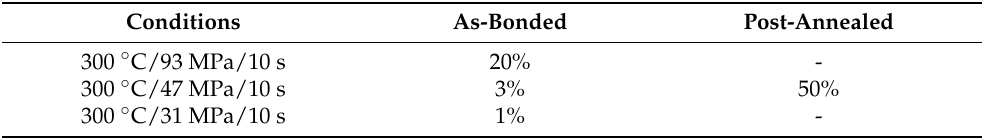
Table 4. Percentage of ductile fracture in a total of 4548